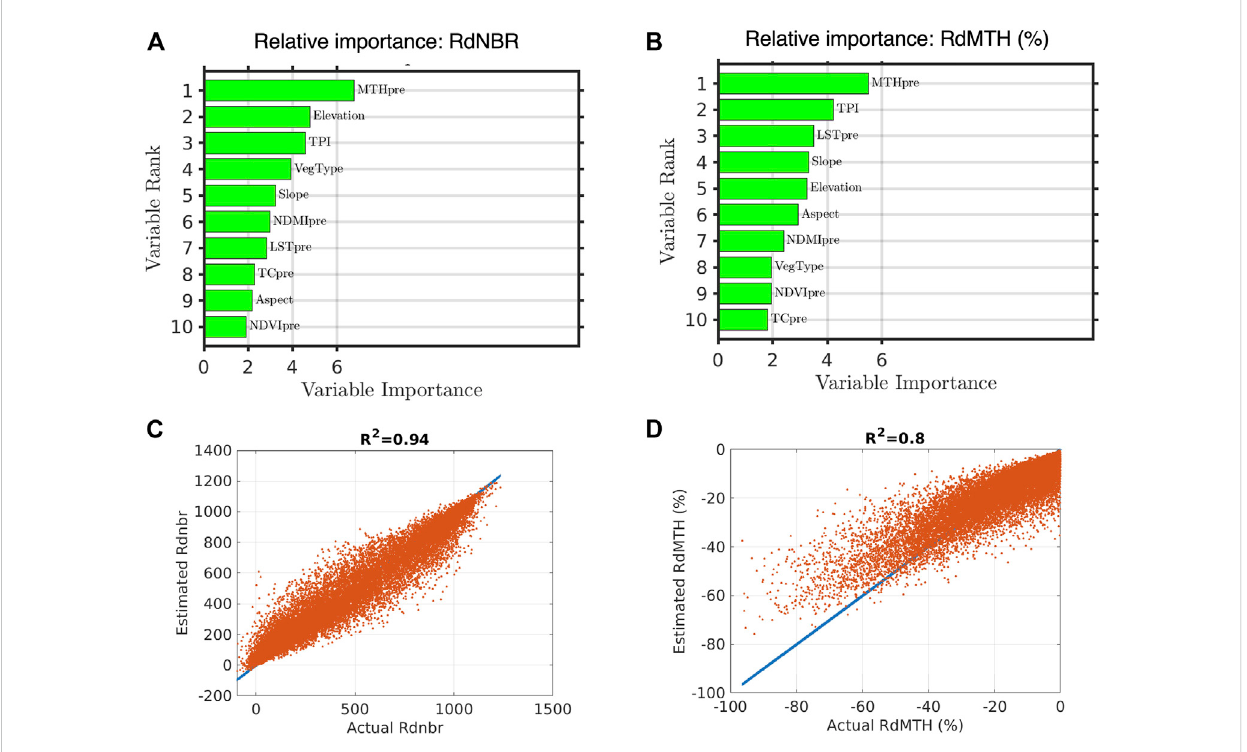
FIGURE 3 Variable importance quanti fi ed from the random forest model for the RdNBR (A) and RdMTH (B) . The performance of the models for theRdNBR (C) and RdMTH (D) evaluated with independent testing